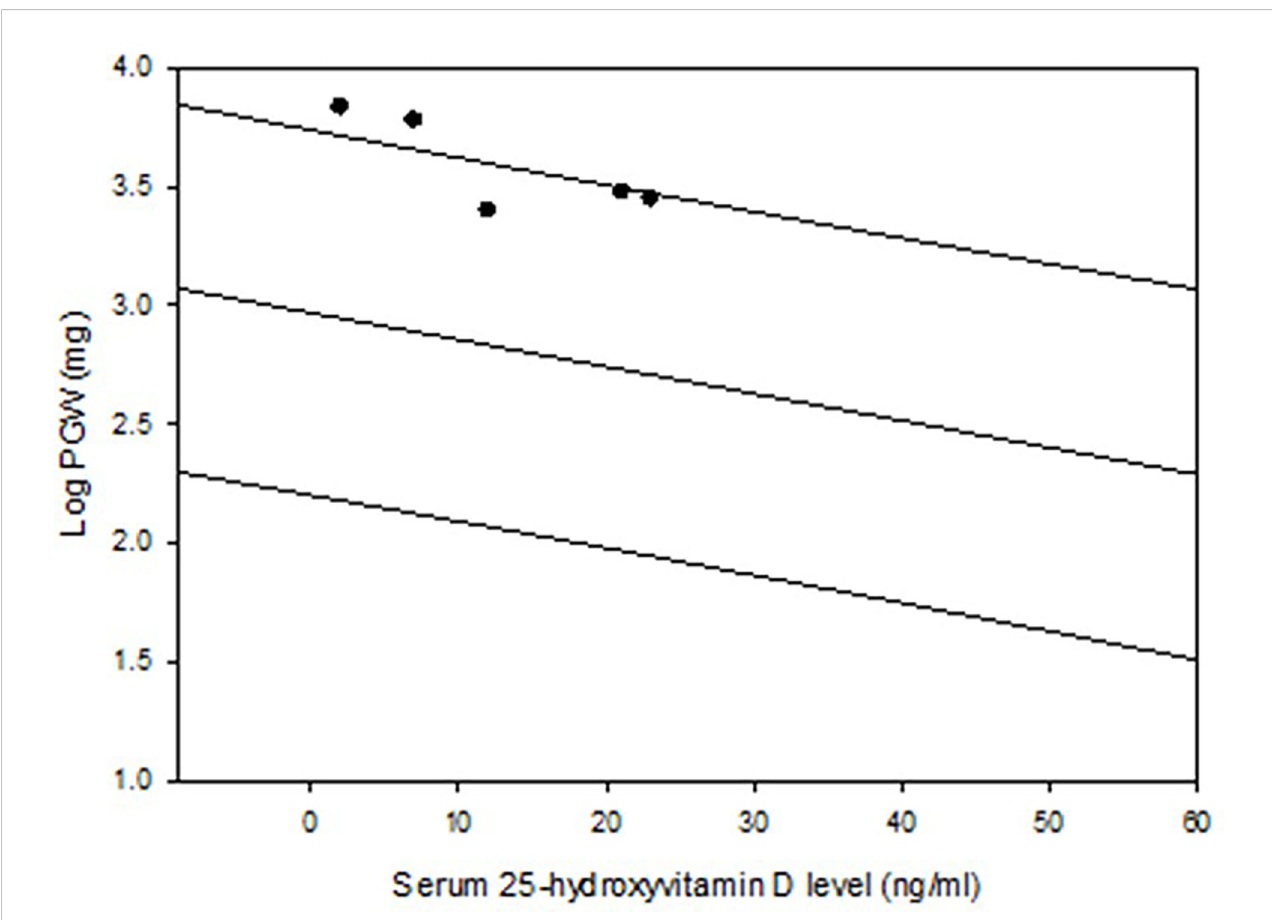
FIGURE 1 Regression and 95% prediction interval of the relationship between serum 25-hydroxyvitamin D level and parathyroid adenoma weight in the Detroit cohort (n=429). The 5 patients with osteitis fi brosa cystica are depicted (closed dots). Note the location of these 5 adenomas near or above the predicted